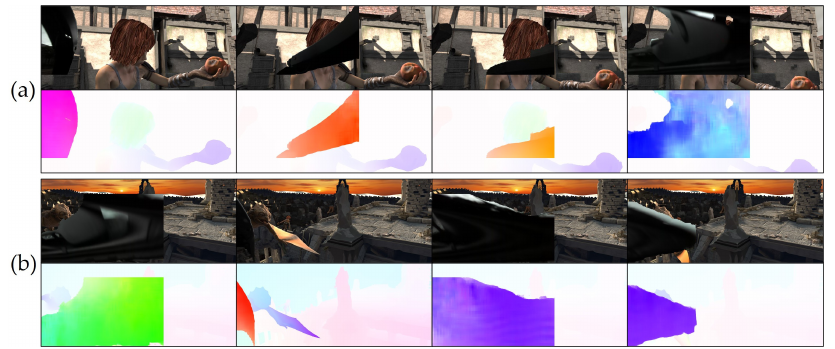
Figure 10. Examples of actual synthesized images and flows in Sintel [30] with scenarios: ( a ) sequen- tial sequence synthesized image sequences of returning and ending states sequentially; ( b ) random synthesized random single images among the states.